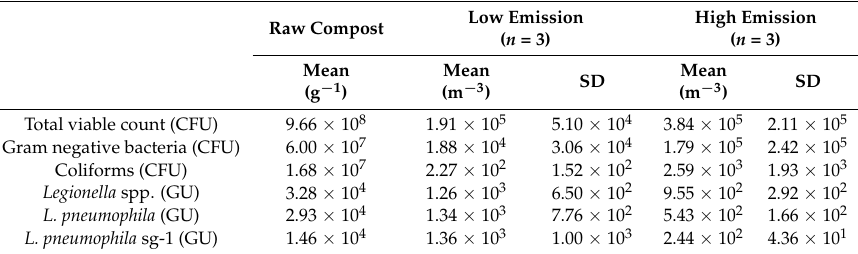
Table 5. Summary of microbiological findings.